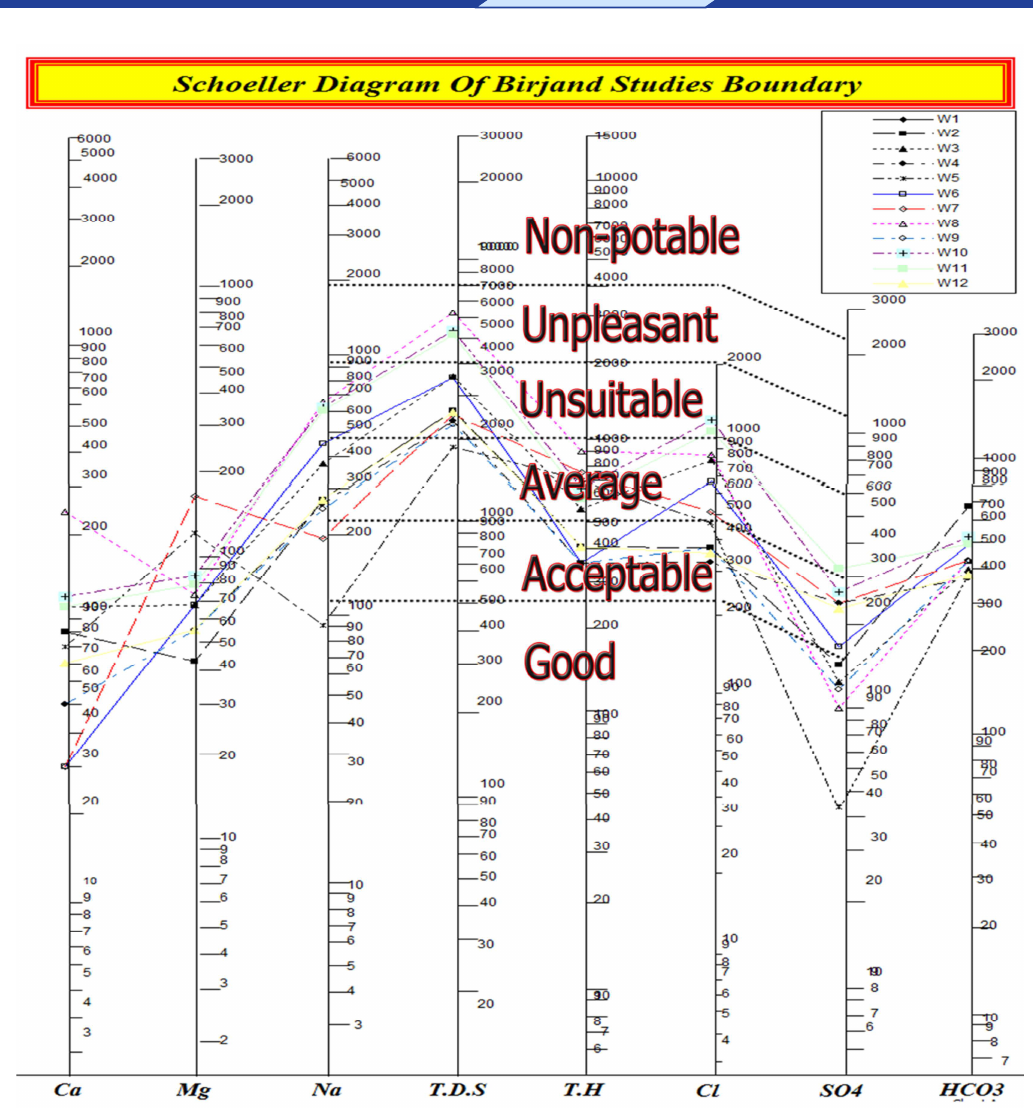
Figure 3. Schoeller diagram of Birjand, Iran f1ood plain TDS: Total dissolved solids; TH: Total